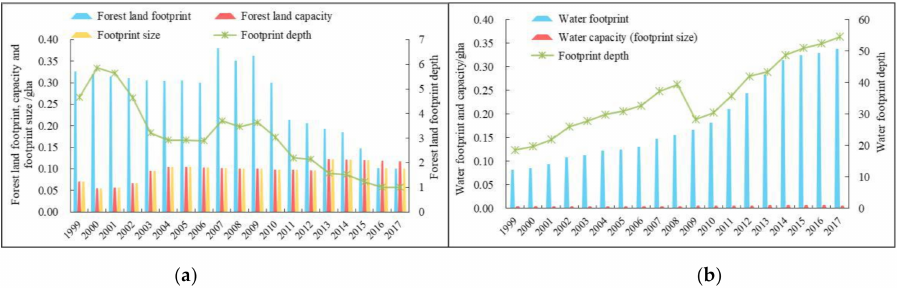
Figure 5. Changes in the natural capital use of forest land ( a ) and water ( b ) in Ningxia from 1999 to